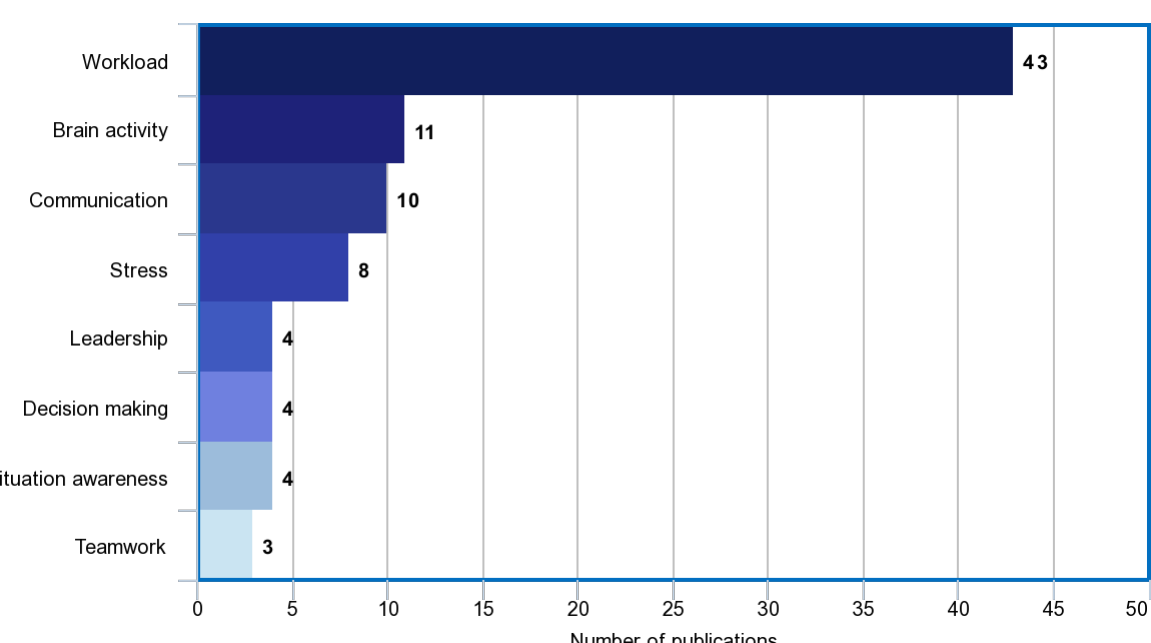
Figure 4. PRISMA chart of the literature search results.